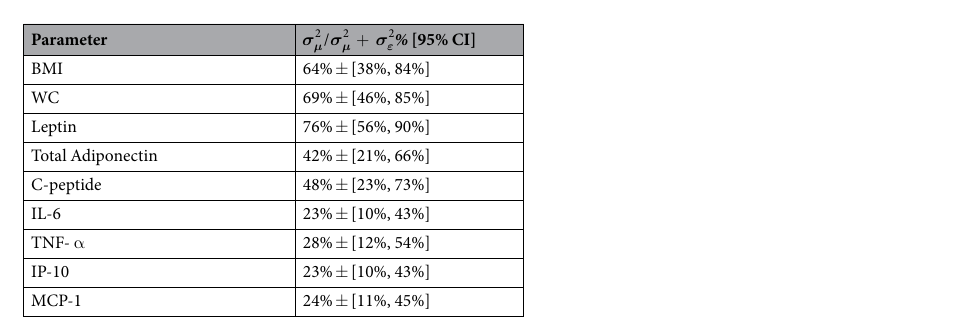
Table 2. Percent of the inter-individual differences in response variables that can be attributed to lipidome profiles, posterior mean [95% Confidence region]. Body mass index (BMI), waist circumference (WC), tumor necrosis factor-alpha (TNF- α ), interferon gamma-induced protein-10 (IP-10), interleukin-6 (IL-6), monocyte chemoattractant protein-1